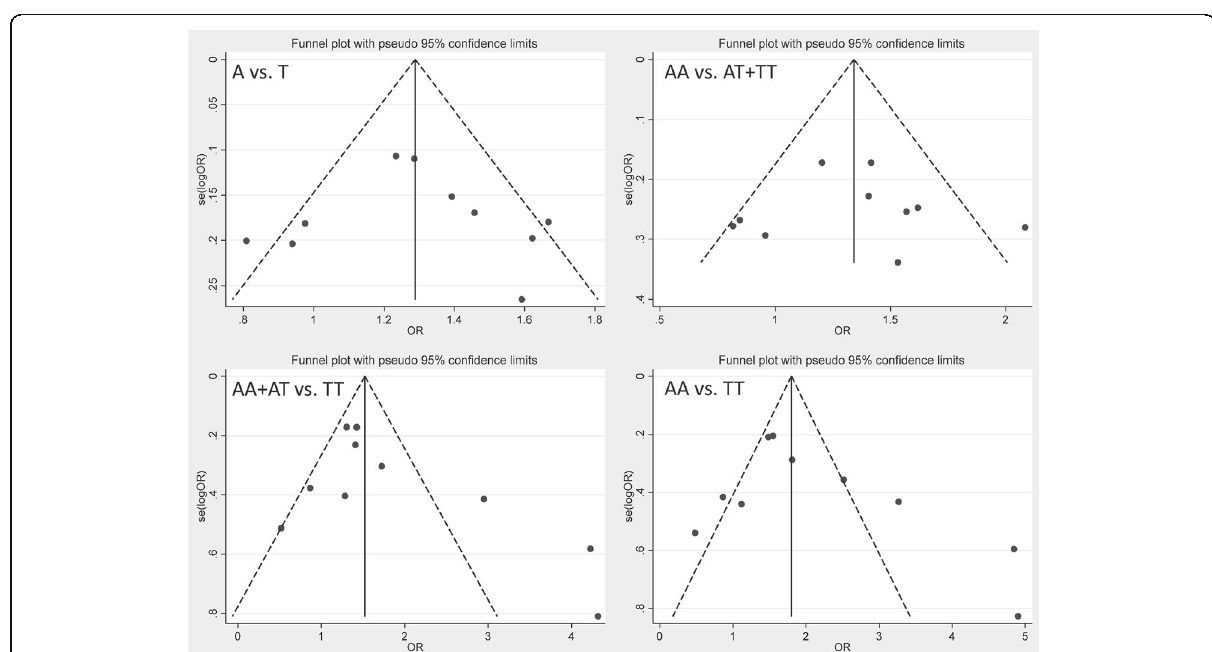
Fig. 5 Begger ’ s funnel plots to evaluate publication bias. The shape of the funnel plot was obviously symmetrical for all genetic